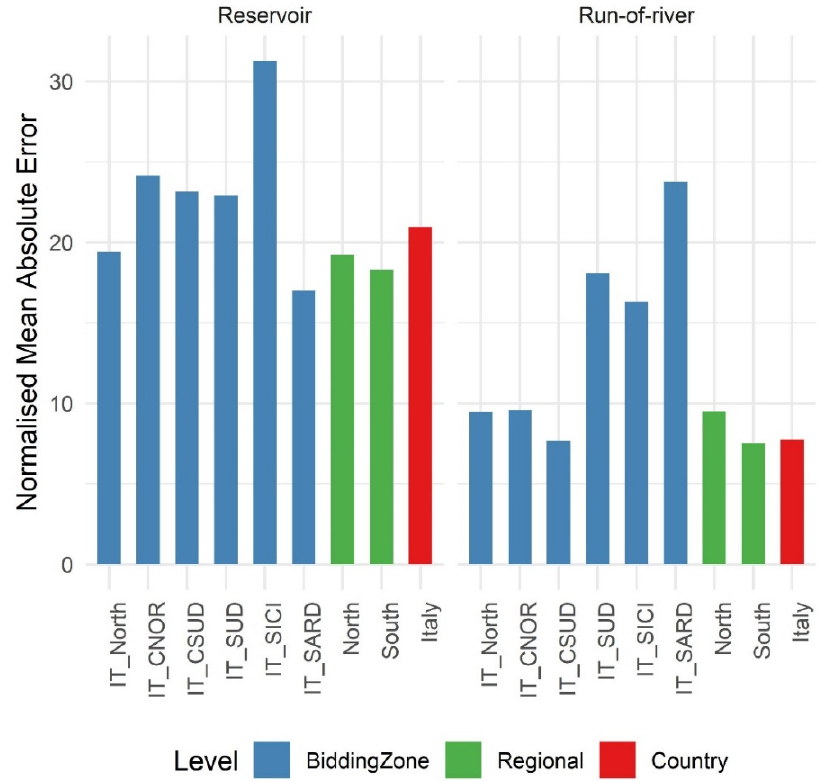
Figure 6. The normalised mean absolute error of the two-step random forest model applied to the six Italian bidding zones, as well as at the two regional aggregation areas (North and South), and at the country level for the period